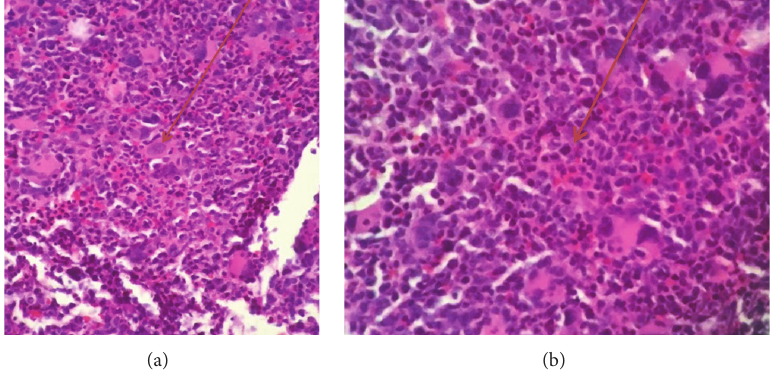
Figure 4: Bone Marrow Core Biopsy: picture (intermediate magnification, H&E) shows a hypercellular bone marrow with increased number of dysplastic megakaryocytes. Dysplastic features include nuclear hypolobation (a) and micromegakaryocytes (b).